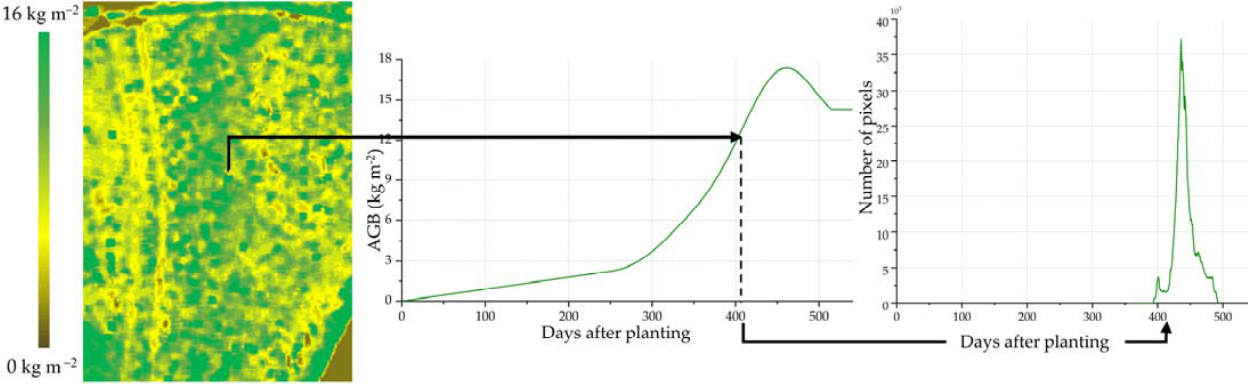
Figure 8. Example of how a histogram is obtained from an estimated AGB map. Left: AGB map. Center: AGB curve. Right: Histogram.